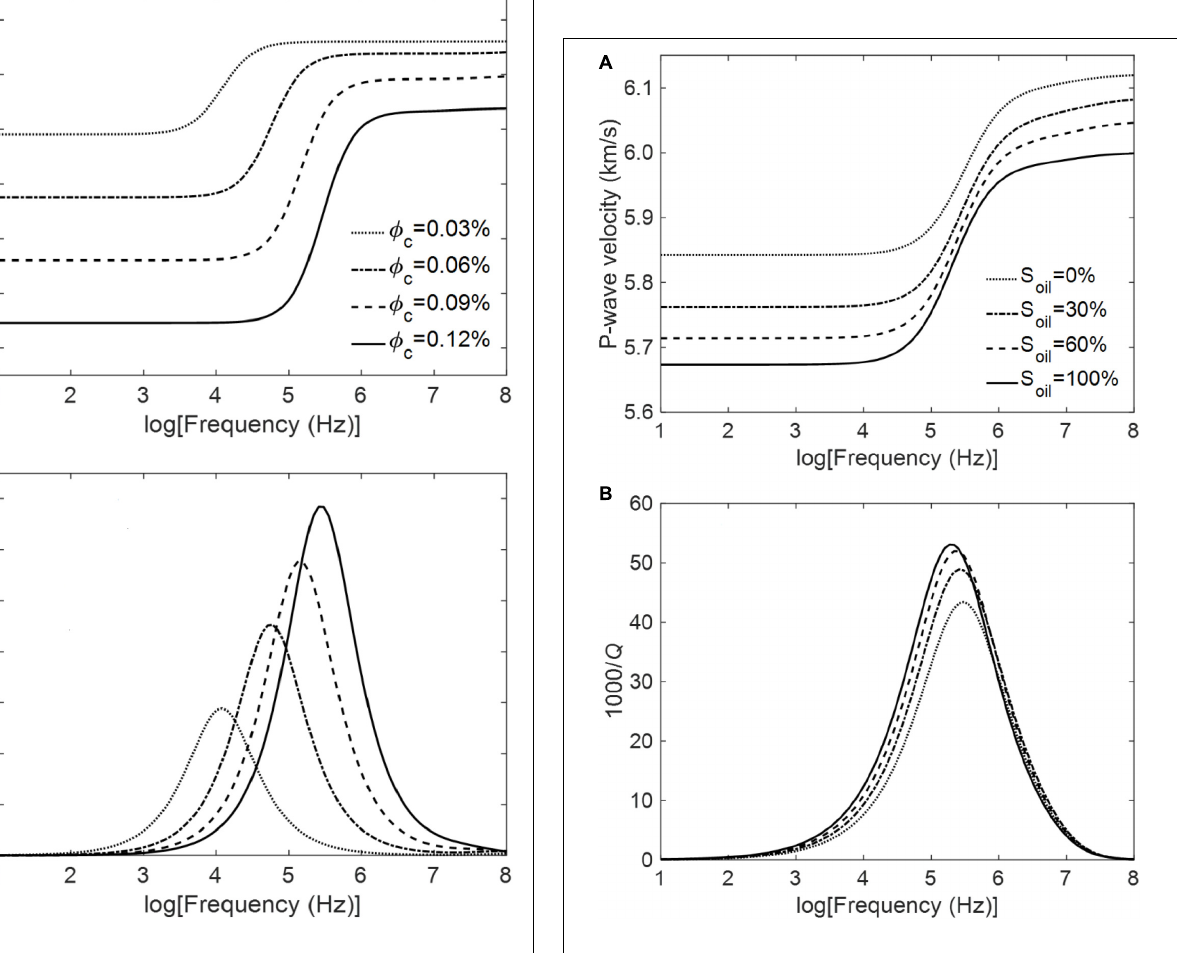
FIGURE 4 | P-wave velocity (A) and attenuation (B) as a function of frequency for varying crack (soft) porosity.